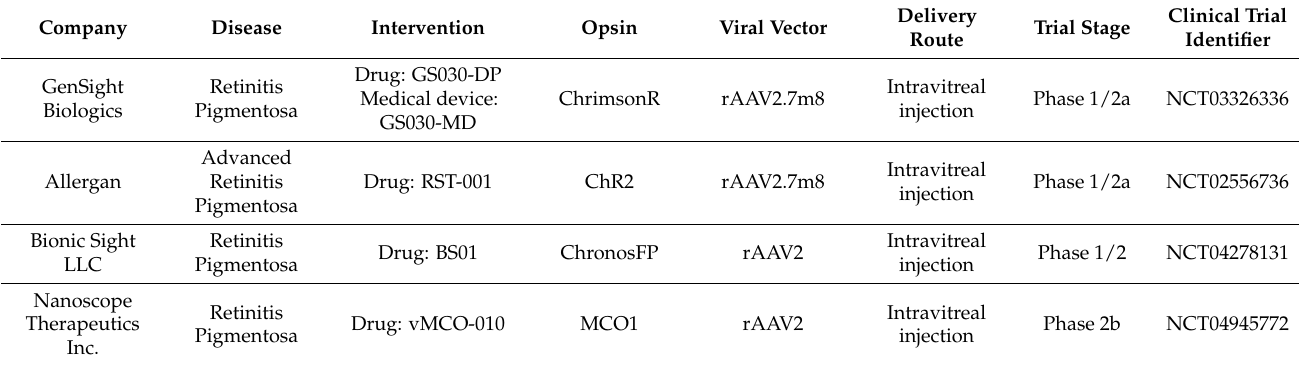
Table 1. Summary of ongoing clinical trials of optogenetic therapy for vision